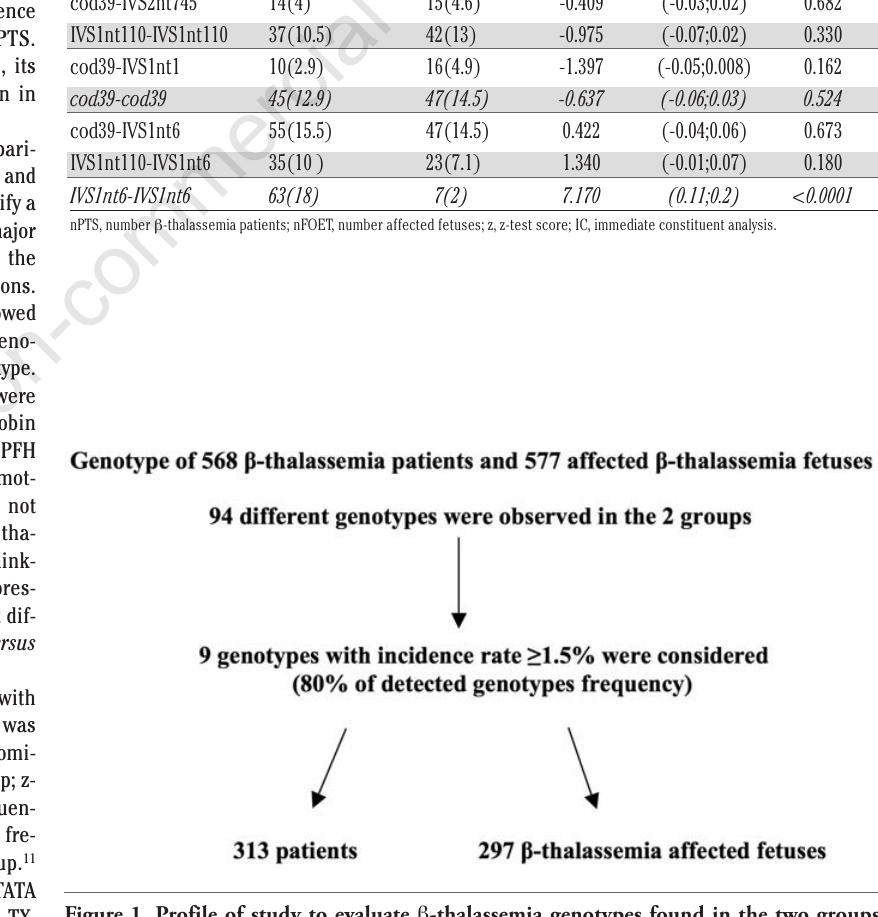
Figure 1. Profile of study to evaluate β -thalassemia genotypes found in the two groups